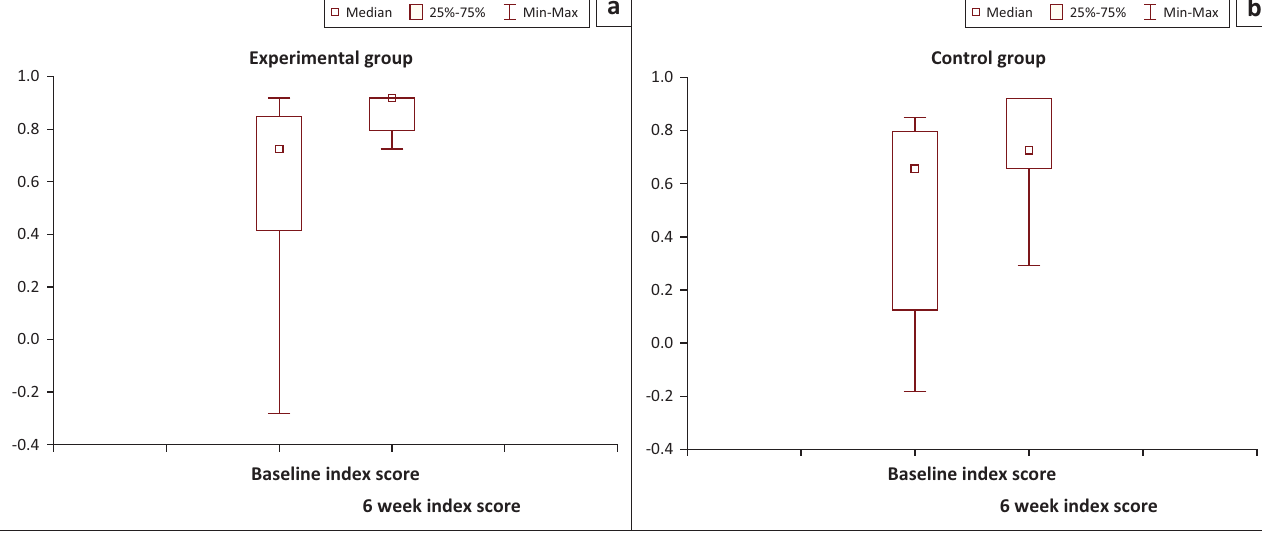
FIGURE 4: Boxplots of within-group differences of EQ-5D-3L index scores from baseline to 6 weeks. (a), experimental group, n = 22, and (b) control group, n = 15.